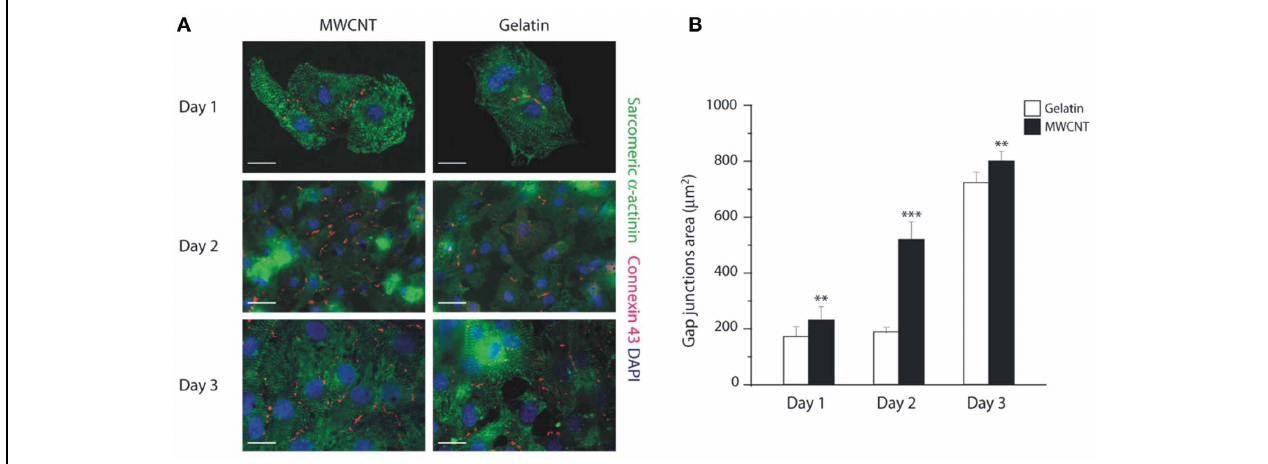
with DAPI (blue). Bars: 50 μ m. (B) The expression of connexin 43 (gap-junctions) after 1, 2, and 3 days culturing is increased in cultures grown on the CNTs scaffold. Reprinted with permission from Martinelli et al. (2013). ∗∗ p < 0 . 01; ∗∗∗ p < 0 . 001.